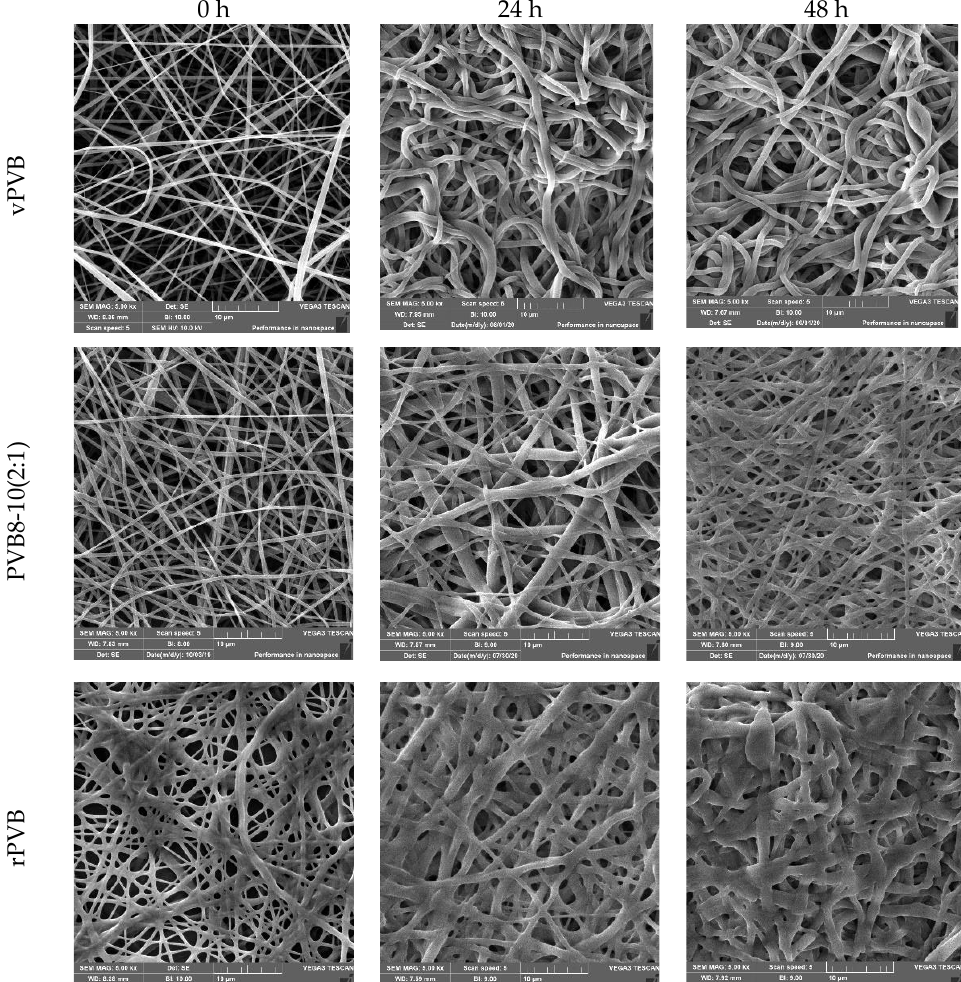
Figure 16. Morphology of electrospun mats after soaking in water (0, 24, and 48 h), scale length = 10 μm.